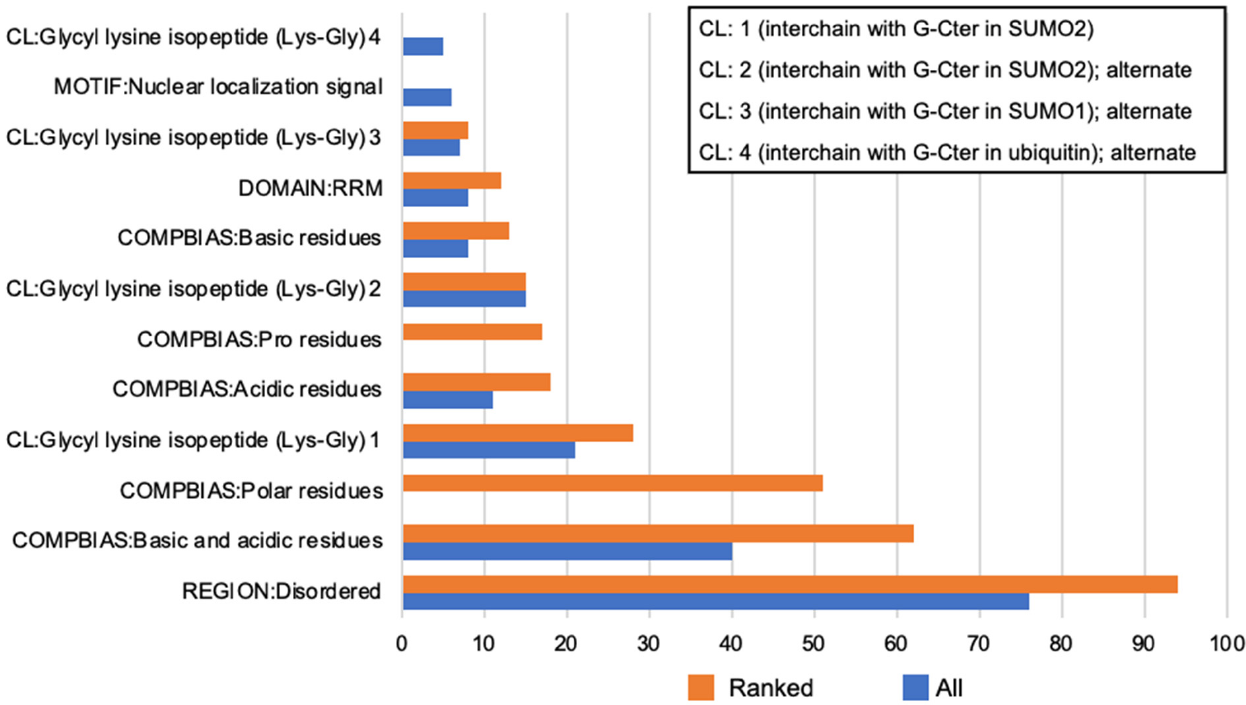
Figure 3. Thermostable protein GO analysis for UniProt Sequence Features. x -axis, percent of submitted genes mapping to y -axis annotation. Annotation terms are highly shared between all thermostable proteins and a subset ranked by RAPID and SLIDER. Compositional bias for polar residues was represented at 36% for all thermostable proteins at default Modified Fisher Exact (EASE score) p < 0.10 but not at p < 0.01 used for other terms. Terms returning < 5% of submitted genes are not shown. CL, CROSSLINKED. COMPBIAS: compositional bias. RRM: RNA recognition motif.